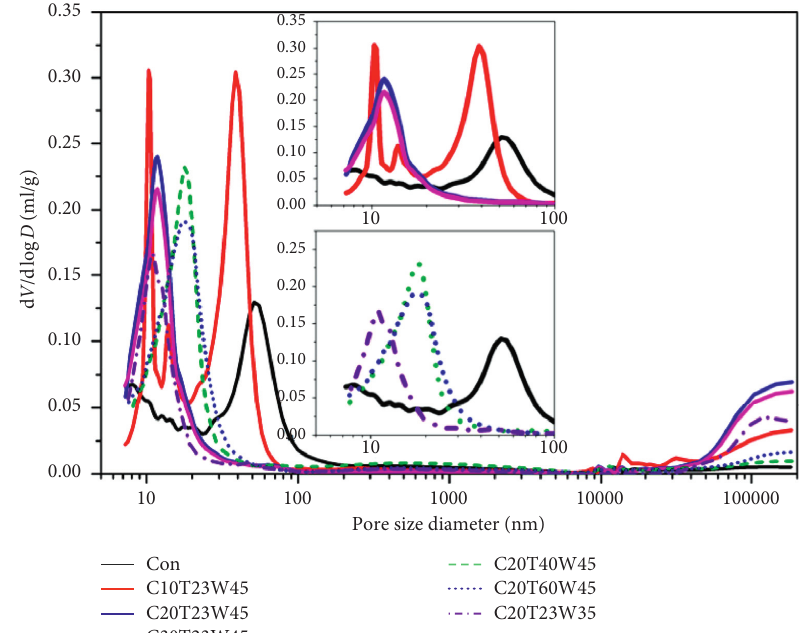
Figure 8: Pore sizes of representative 28d mortars.